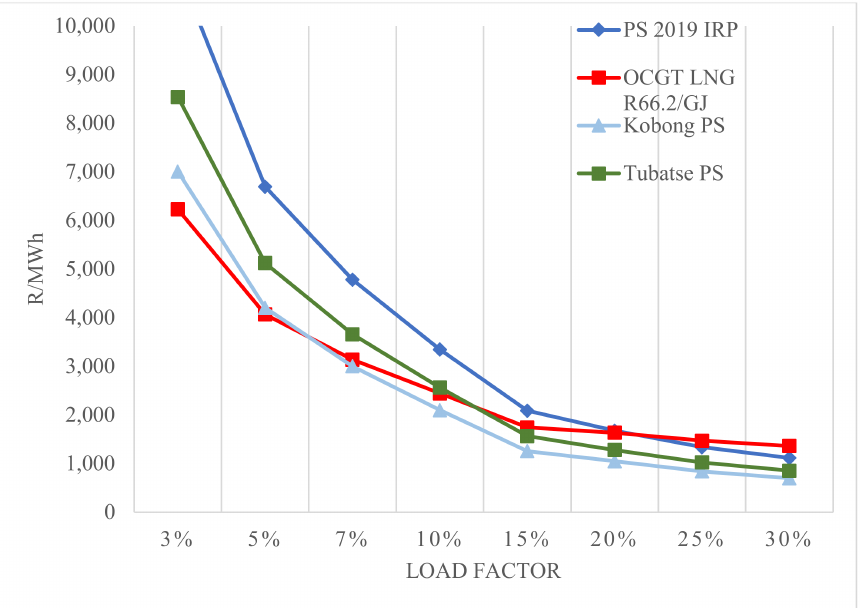
Figure 5. LCOE curves for IRP 2019, including alternative costing inputs based on Tubatse and